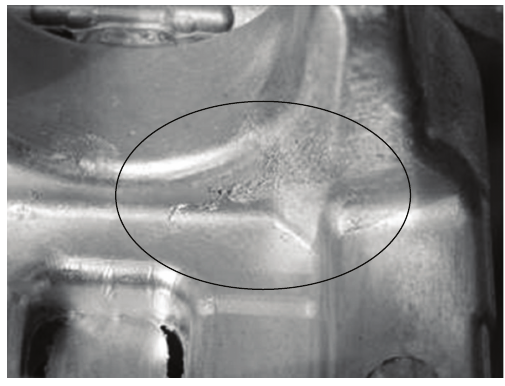
Figure 4: An example of a cold shut defect brake caliper casting produced during trials with the CSIR-RCS-HPDC cell.